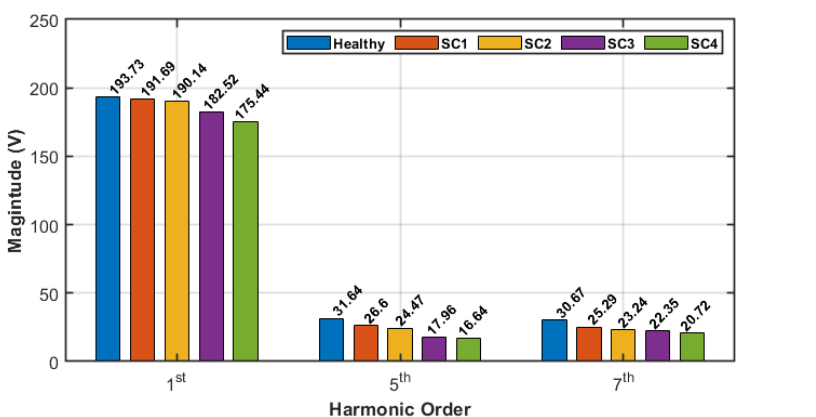
Figure 10. Variations in the harmonic content of stator voltage spectrum for healthy and faulty machine under TTSC fault in FOC